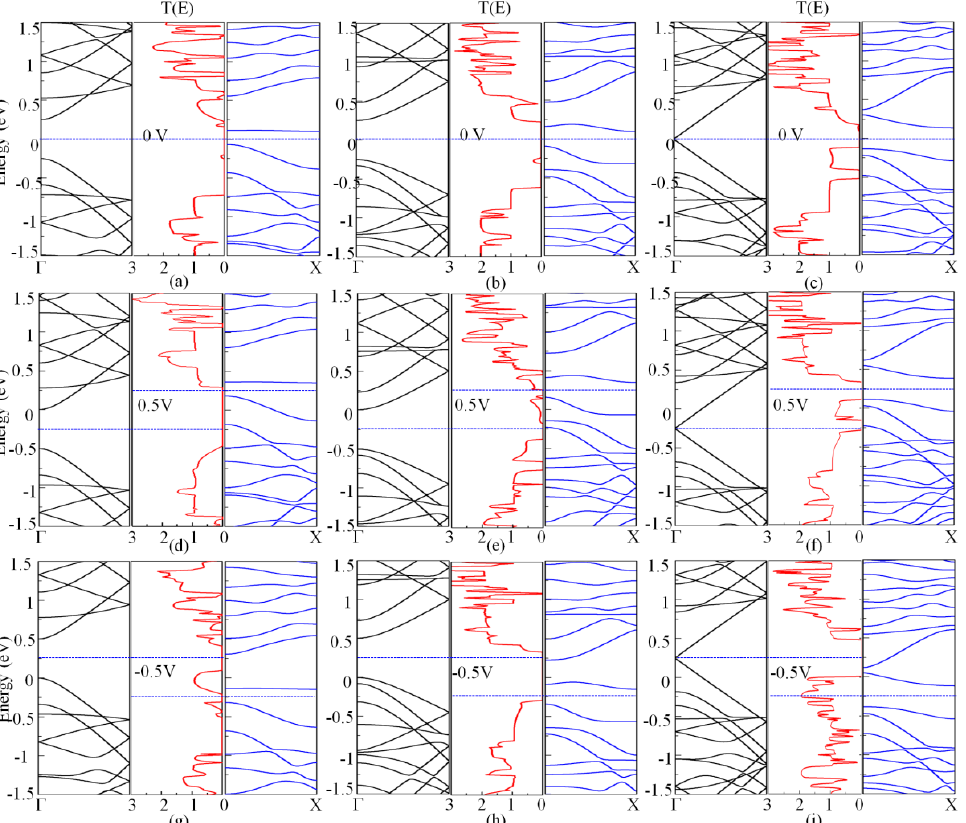
Figure 6. Band structure for the left lead (left panels), transmission curve (middle panels), and band structure for the right lead (right panels). ( a – c ) A6/7/8-E devices under a zero bias (0 V); (def) A6/7/8-E devices under a 0.5 V bias; ( g – i ) A6/7/8-E devices under a − 0.5 V bias. The blue dashed lines correspond with the chemical potentials of the left and right electrodes.